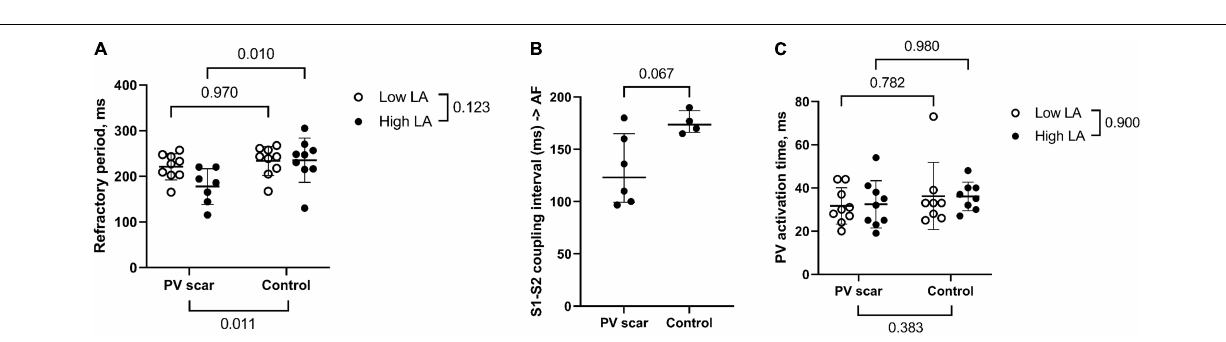
FIGURE 7 | PV refractoriness and activation time. (A) The refractory period was reached in programmed stimulation protocols without AF and was in high LA pressure shorter in PV scar hearts than control hearts ( n = 7 vs. n = 9, respectively). A refractory period was not reached in 2 PV scar hearts (cf. n = 7). Therefore, a mixed-effects linear model was performed. (B) In high LA pressure, there was a tendency toward a shorter S1–S2 coupling interval causing AF in hearts with PV scar compared with control ( n = 6 vs. n = 4, respectively, Mann–Whitney U test). S1 stimulation (without a premature stimulus) also caused AF. (C) The PV activation time (range in the activation time within the PV area including both LPV and RPV) during sinus rhythm was unaltered by the presence of a PV scar as tested with a mixed-effects linear model ( n = 9 vs. n = 8, PV scar vs. control. Electrical noise disturbed the electrograms in 1 control heart, and this recording was omitted from the